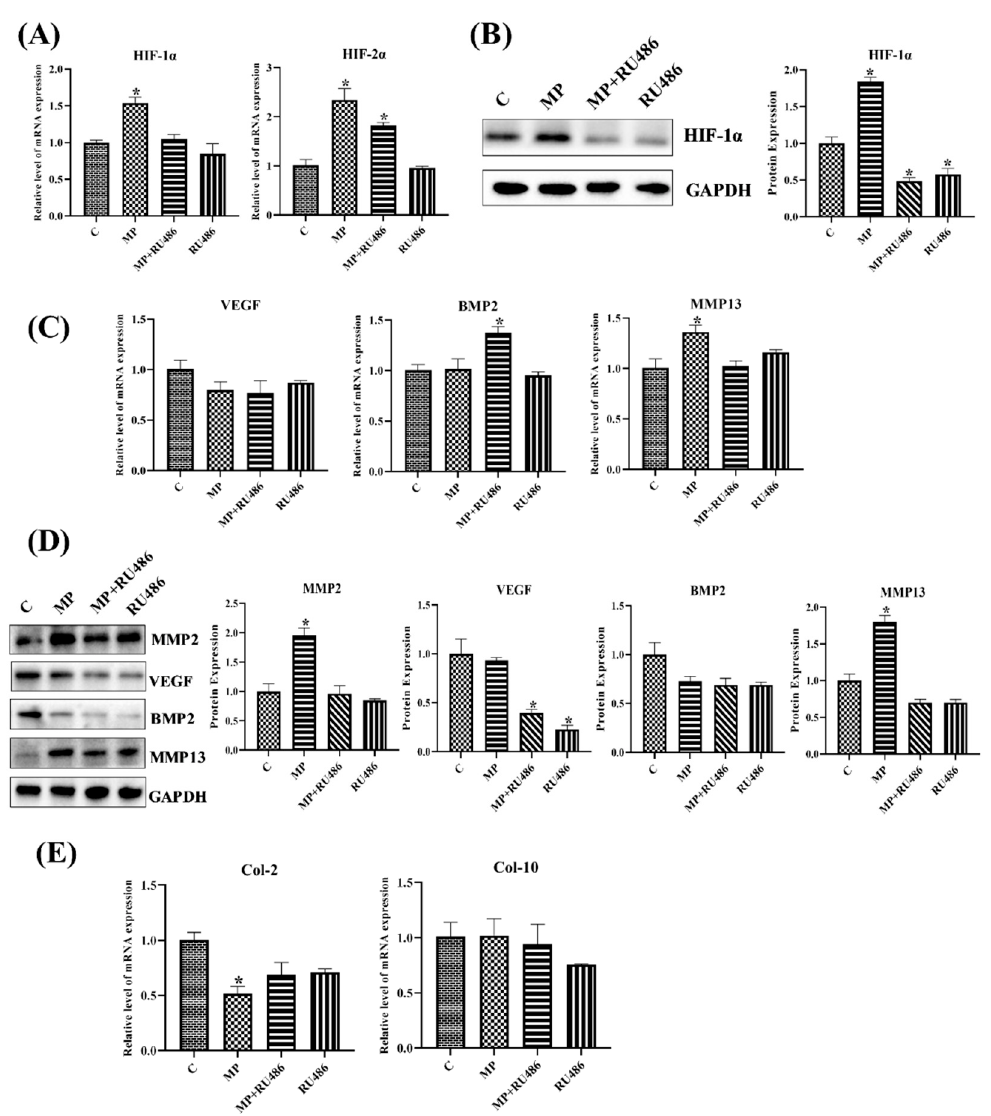
Figure 8. The expressions of related factors in chondrocytes with RU486-treatment. ( A ) The mRNA expressions of the HIF pathway in chondrocytes. ( B ) The protein expressions of HIF-1 α in chondrocytes. ( C ) The mRNA expressions of homeostasis-related genes in chondrocytes with different treatments. ( D ) The protein expressions of homeostasis-related factors in chondrocytes. ( E ) The mRNA expressions of ECM in chondrocytes. Here, * p < 0.05 vs. control